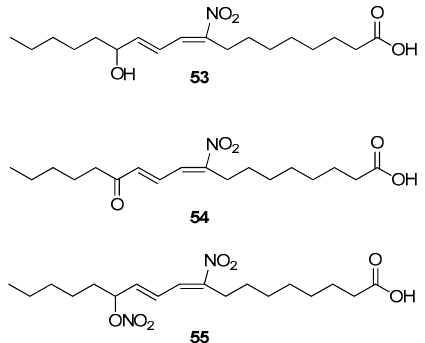
Scheme 8. Degradation products after incubation of 9-NO 2 -LA at pH 7.4.